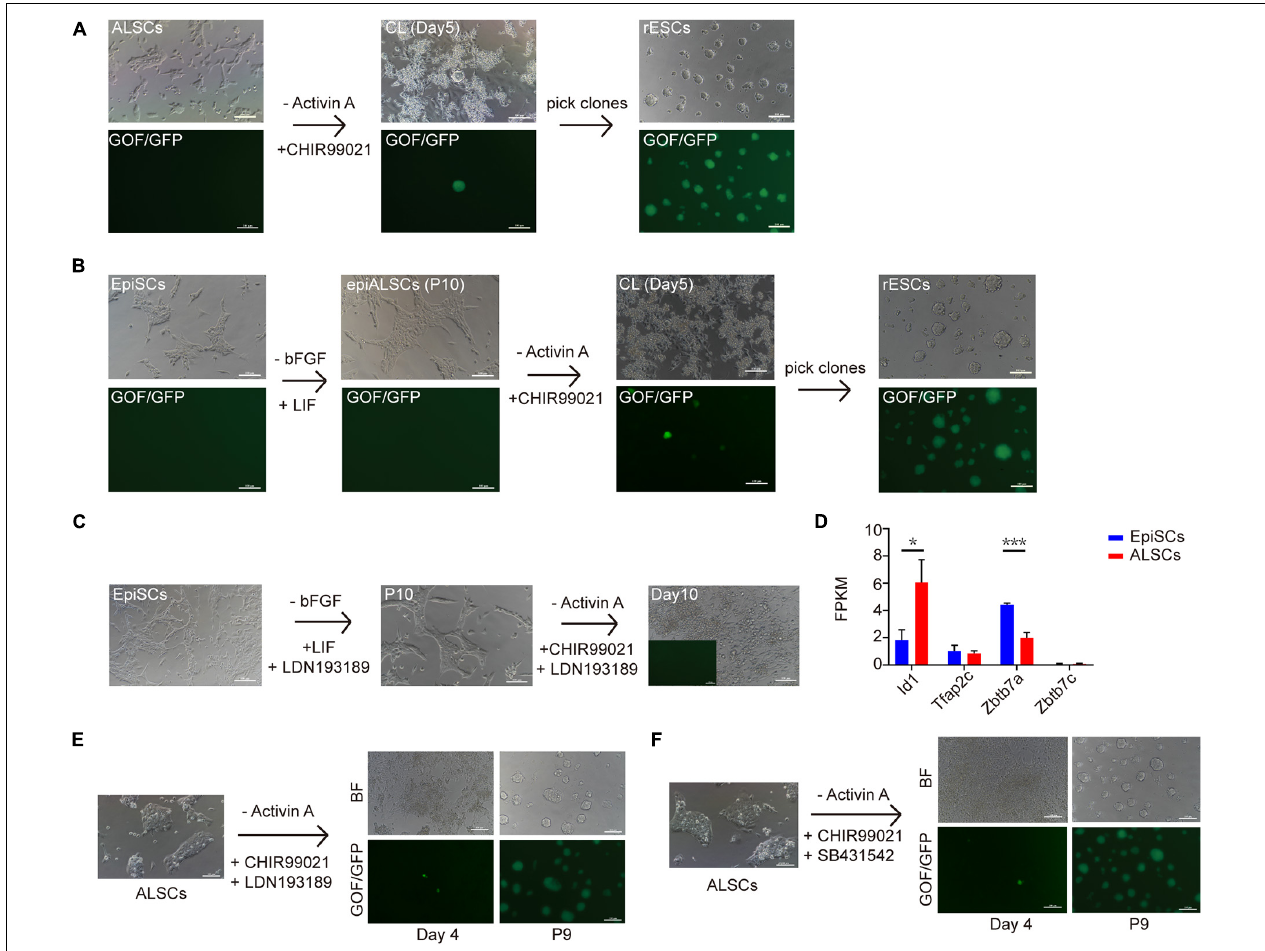
FIGURE 4 | Conversion of ALSCs to rESCs. (A) Morphological changes and rESC induction process of ALSCs. Scale bars, 100 µ m. (B) Morphological changes and rESC induction process of EpiSCs. Scale bars, 100 µ m. (C) Morphological changes and rESC induction process of EpiSCs supplemented with LDN193189 (BMP4 inhibitor) in AL medium and CL medium. Scale bars, 100 µ m. (D) The ALSCs maintenance was independent of BMP signaling. Error bars indicate three independent biological replicates (mean ± SD). *P < 0.05, * *P < 0.001, ** *P < 0.0001. (E) Morphological changes and rESC induction process of ALSCs supplemented with LDN193189 (BMP inhibitor) in CL medium. Scale bars, 100 µ m. (F) Morphological changes and rESC induction process of ALSCs supplemented with SB431542 (Act A inhibitor) in CL medium. Scale bars, 100 µ m.